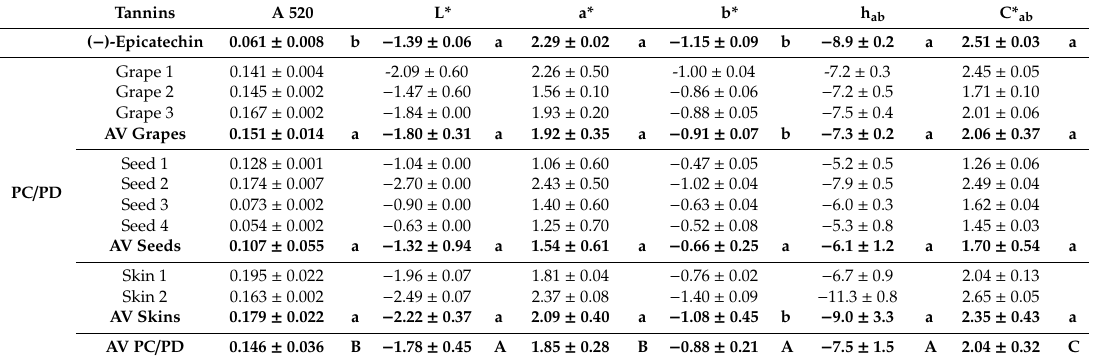
Table 1. Copigmentation e ff ectiveness (Cp) of model wine solution of malvidin-3- O -glucoside (50 mg / L) supplemented with increasing concentration of ( − )-epicatechin or oenological tannins after one week of